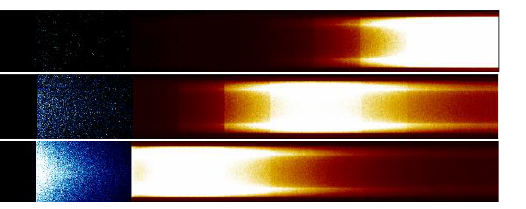
Figure 24. Fission power distribution for Zero-diffusion case, ϒ=69%: burnup steps 40, 200, and 420 GWd/t (top to bottom).